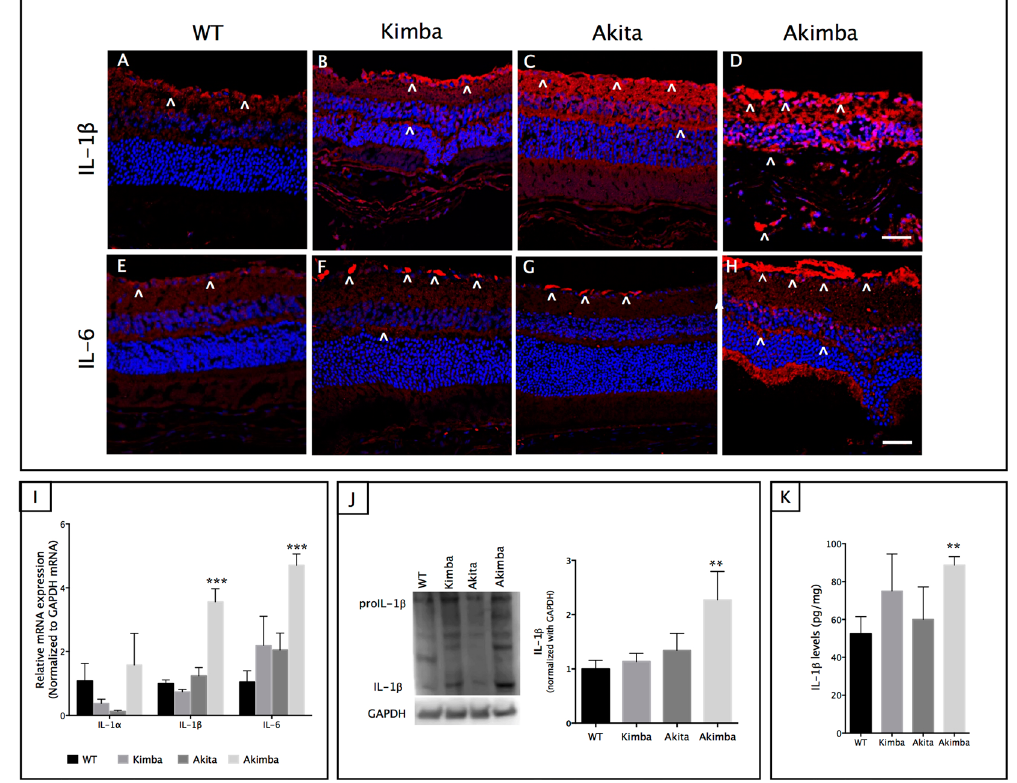
Figure 6. Akimba mice showed significantly high levels of the inflammatory milieu. Immunostaining with IL-1 β ( A – D ) and IL-6 ( E–H ) showed basal levels of these cytokines in the WT ( A, E , respectively), which were markedly increased in all the mice models studied. Akita showed diffused expression of IL-1 β from the GCL to the OPL ( C ), which gradually increased in Kimba ( B ) followed by maximal expression in the Akimba ( D ) retina where we found its expression to be localized in the entire retina. We observed few specks of IL-6 staining in the GCL of WT ( E ) mice, with increasing expression levels from Akita ( G ), Kimba ( F ) with maximal expression in Akimba ( H ). Real-time PCR ( I ) followed the similar expression trend seen in immunostaining. The most remarkable findings were the significant high levels of IL-1 β expression exclusively in Akimba retina found in western blots ( J ) and recapitulated with ELISA ( K ). n = 4 retina per group for immunohistochemistry, qPCR, western blot and ELISA; repeated twice. Arrowheads in A – H indicate IL-1 β and IL6-positive cells. ** p < 0.01; *** p < 0.001 compared to WT group. Data represent mean ± SD. Scale bar, 50 µ